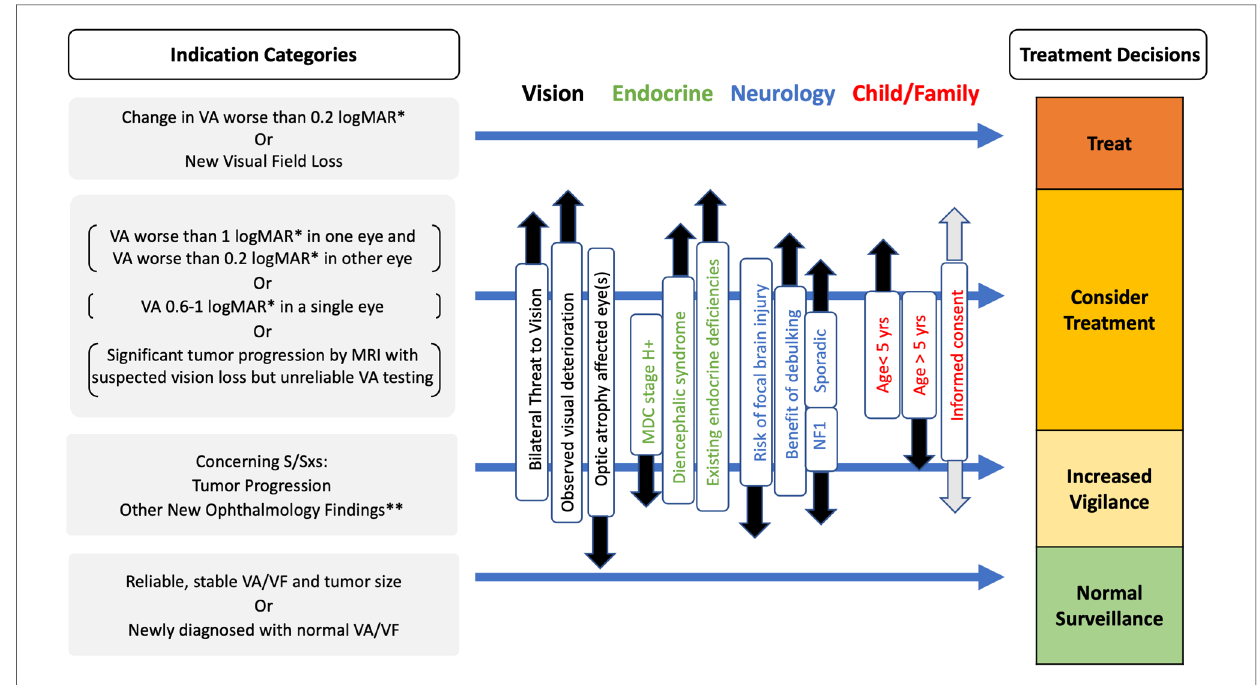
FIGURE 5 Evidence-based multi-disciplinary factors to be considered for selection of treatments (surgery, chemotherapy or radiotherapy) vs. observation in OPHG of infancy and childhood in OPHG Adapted from (3, 46,